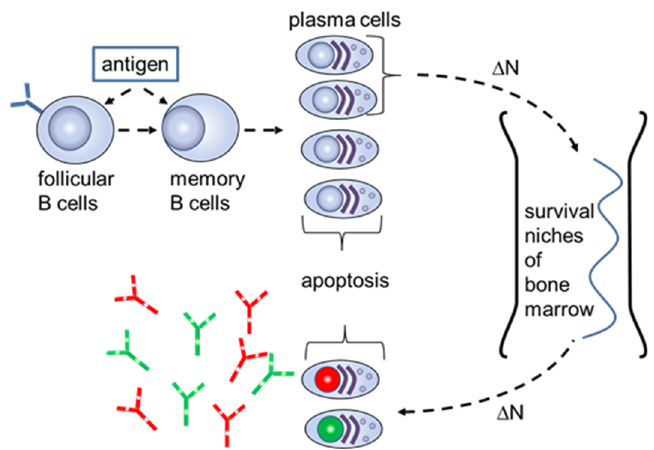
Figure 2. Schematic of the long-term humoral memory via elimination of the long-lived plasma cells for “old” antigens (red and green nucleus) with plasmablasts with a new specificity (lilac nucleus).